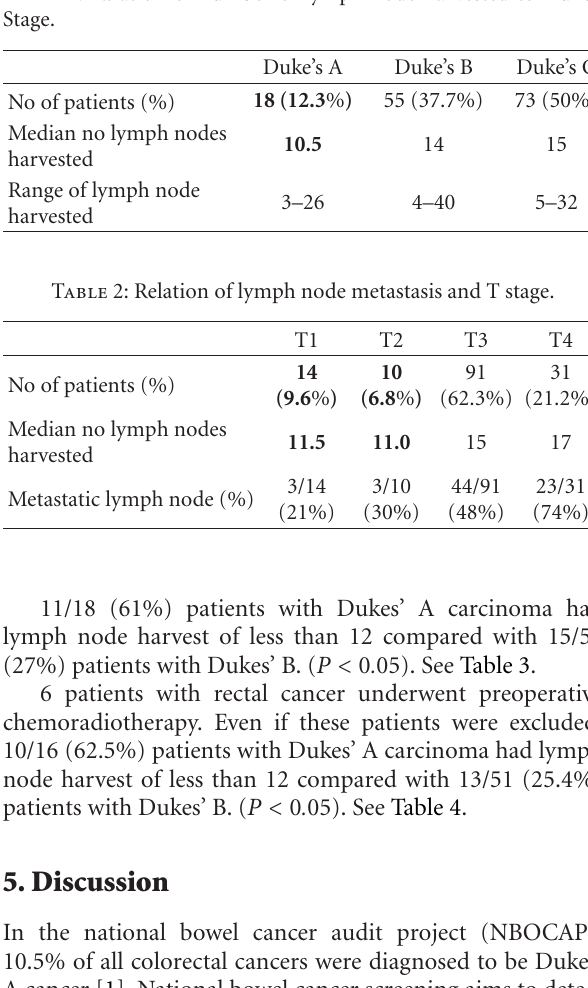
Table 3: Corelation between lymph node harvest and Dukes’ stage.